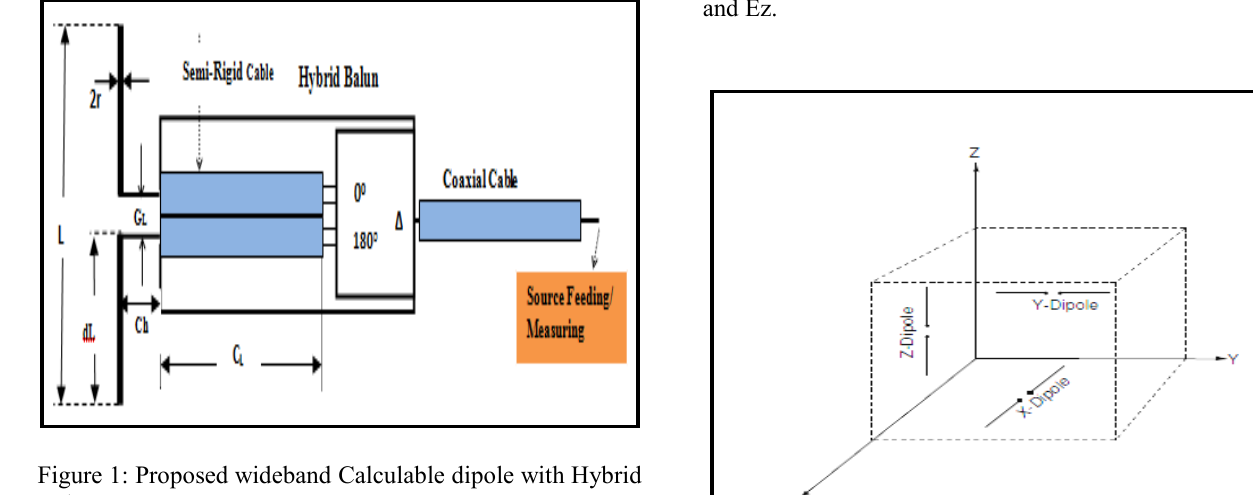
Figure 1: Proposed wideband Calculable dipole with Hybrid Balun Two symmetrical dipole arms placed on Y-axis and gap between two dipoles is GL in millimetre, the length of the coaxial outer is CL, and the total length of the coaxial inner is CL+Ch, the Inner connector is soldered to dipole arm by length Ch above the outer conductor.